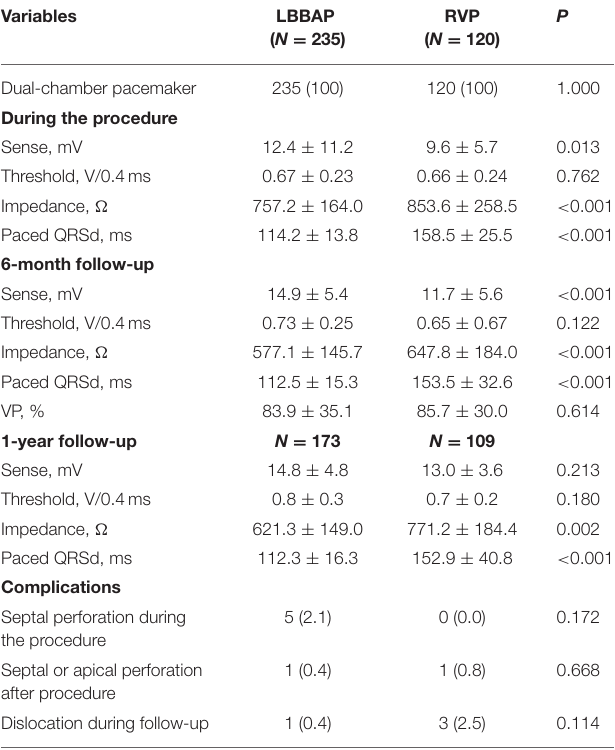
Figure 4F ) in patients without baseline organic cardiac disease or atrial